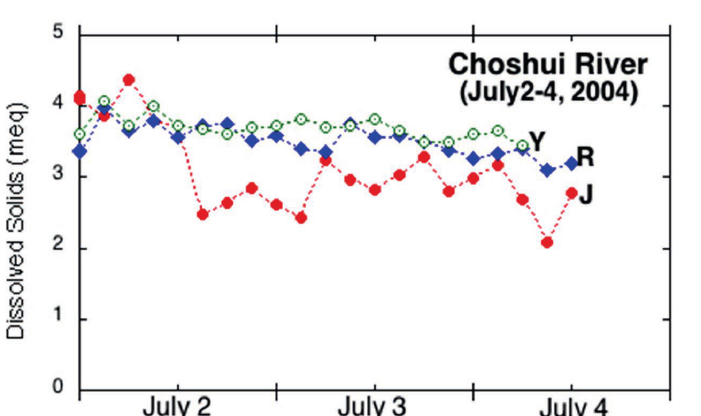
Fig. 8 Measured total dissolved solids, reported in milliequivalents (meq). In contrast to the suspended sediments (Fig. 5), station R has roughly similar dissolved solid concentrations to those measured at station S. The lower concentrations noted at station J can be explained in part by higher discharge at this downstream